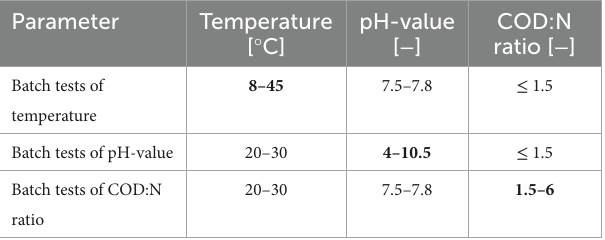
TABLE 2 Operational parameters tested in laboratory batch